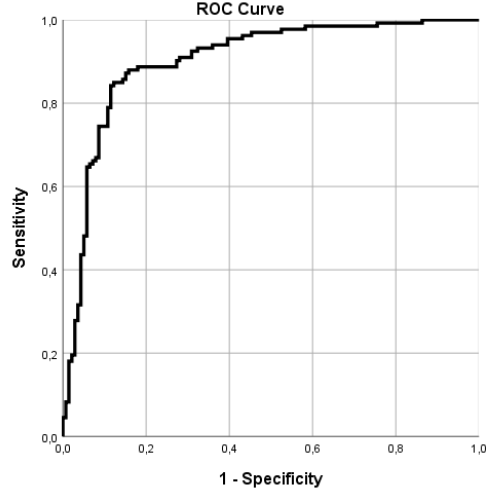
of 85.3 ( p < 0.001) with SE of 82.7%, SP 88.5%, VPP 87.3%, and VPN 84.2%. 82.7%, SP 88.5%, VPP 87.3%, and VPN 84.2%.